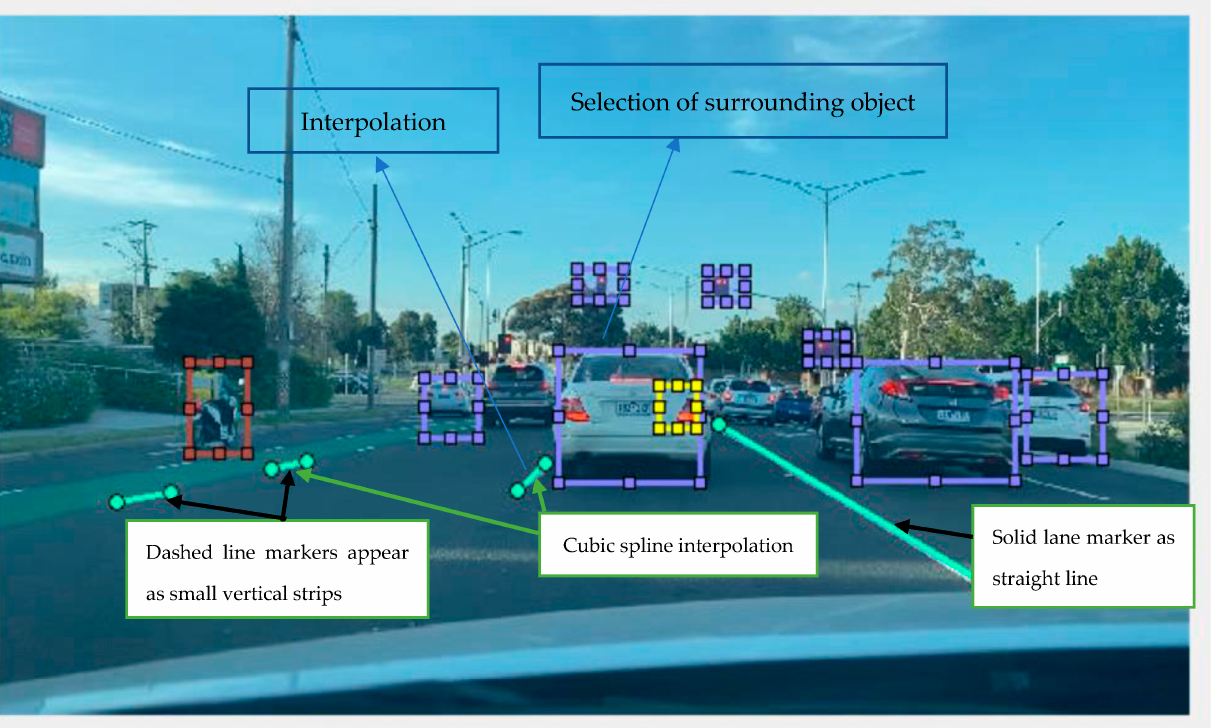
Figure 5. Generating ground truth annotation.